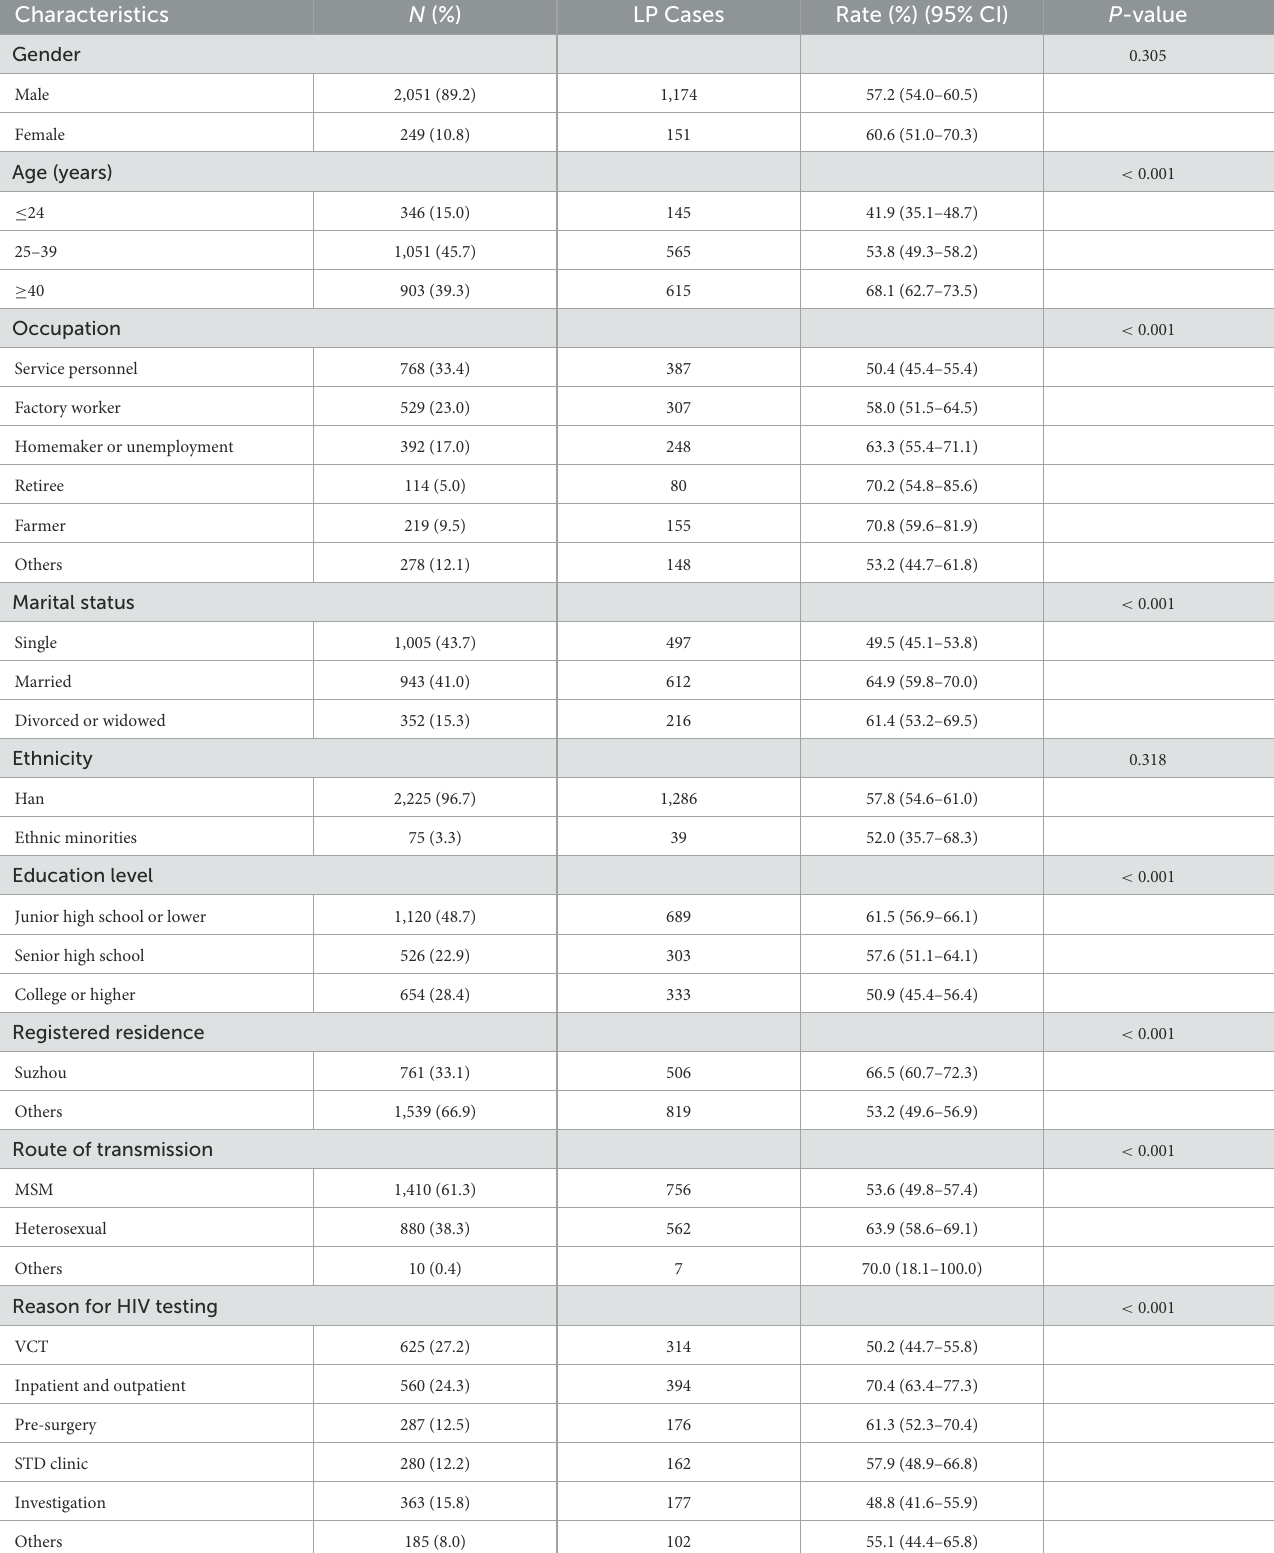
TABLE 1 Socio-demographic characteristics and late presentation among patients with newly diagnosed